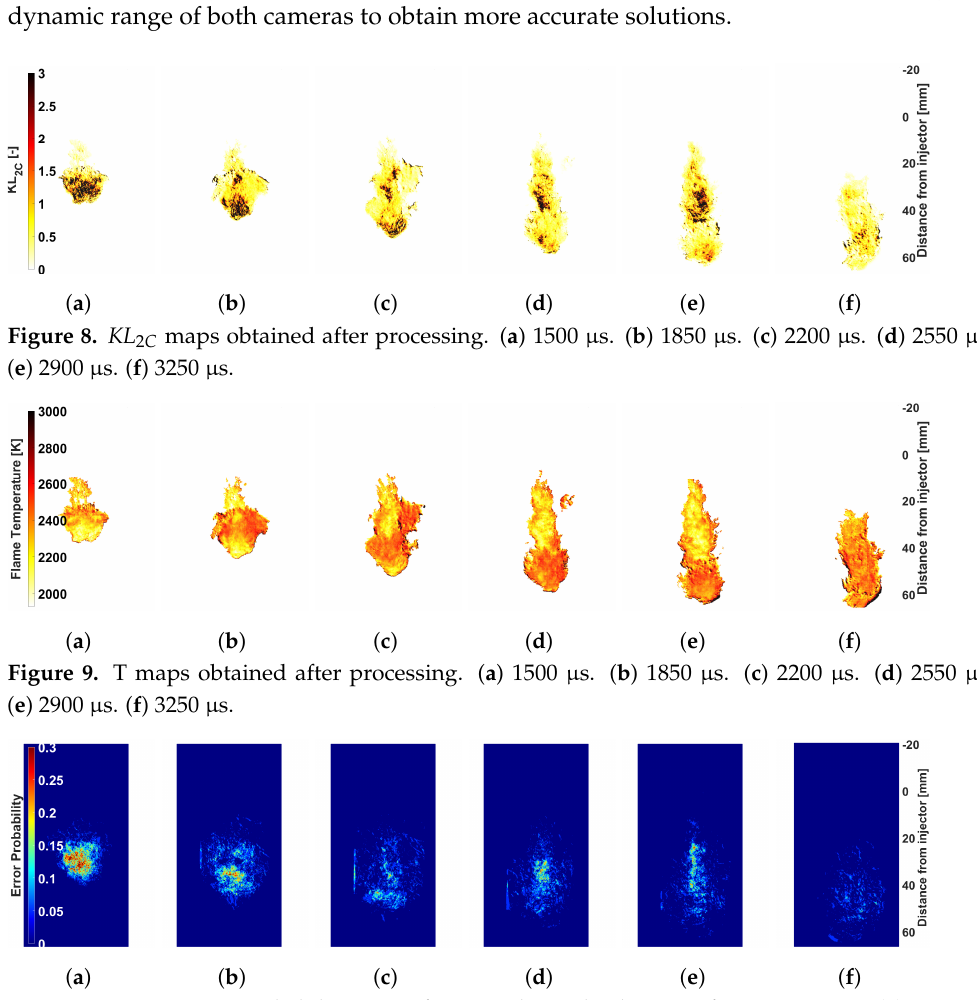
Figure 10. Error zone probability maps for non-physical solutions after processing. ( a ) 1500 µ s. ( b ) 1850 µ s. ( c ) 2200 µ s. ( d ) 2550 µ s. ( e ) 2900 µ s. ( f ) 3250 µ